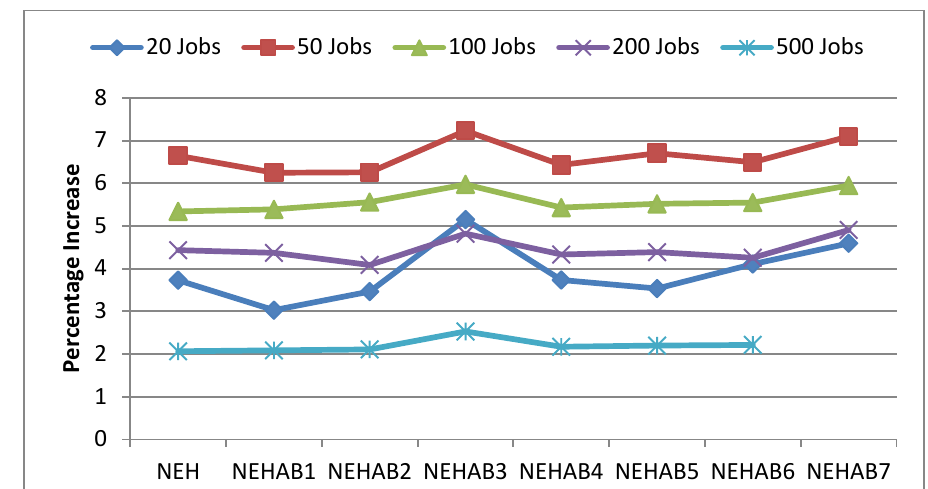
Fig. 2. Percent Increase Plot for 10 Machines